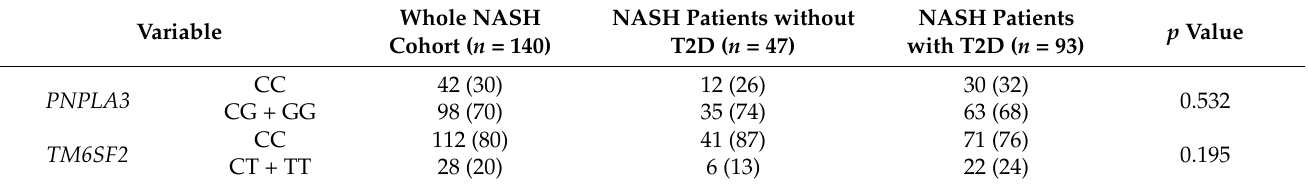
Table 3. Allelic distribution in the entire NASH cohort and subdivided respect to T2D